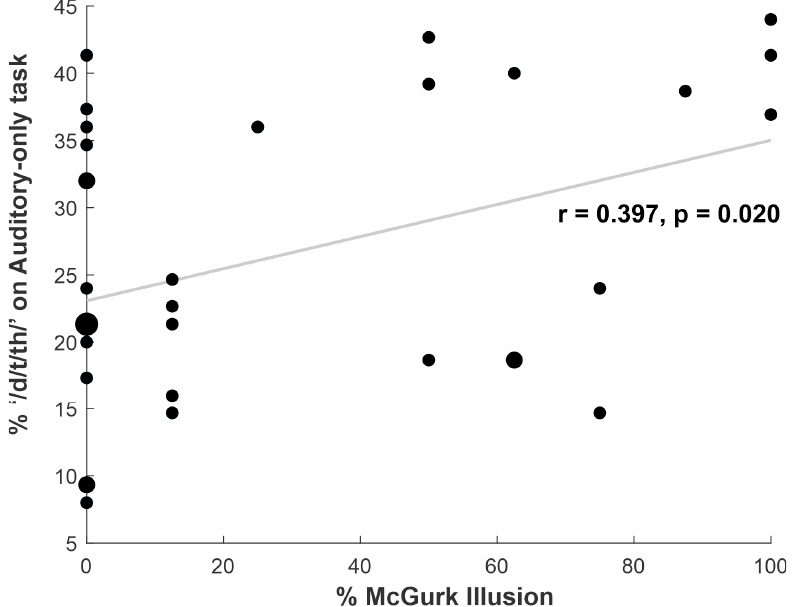
Figure 3. Results of the correlation between /d/t/th/ perception on McGurk trials and on the Auditory-only task. The dots represent individual participants; enlarged dots depict data points shared by two or more participants, with dot size proportional to the number of overlapping participants.